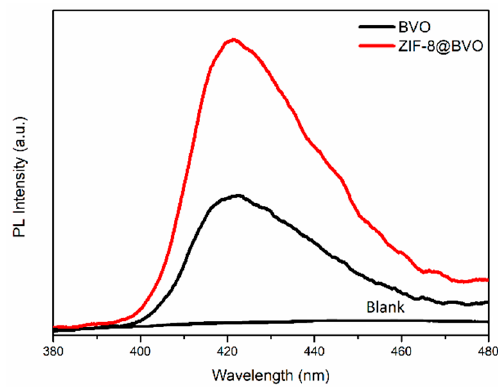
Figure 4. Photoluminescence spectra of the terephthalic acid (TA) solution after irradiating for 100 min.